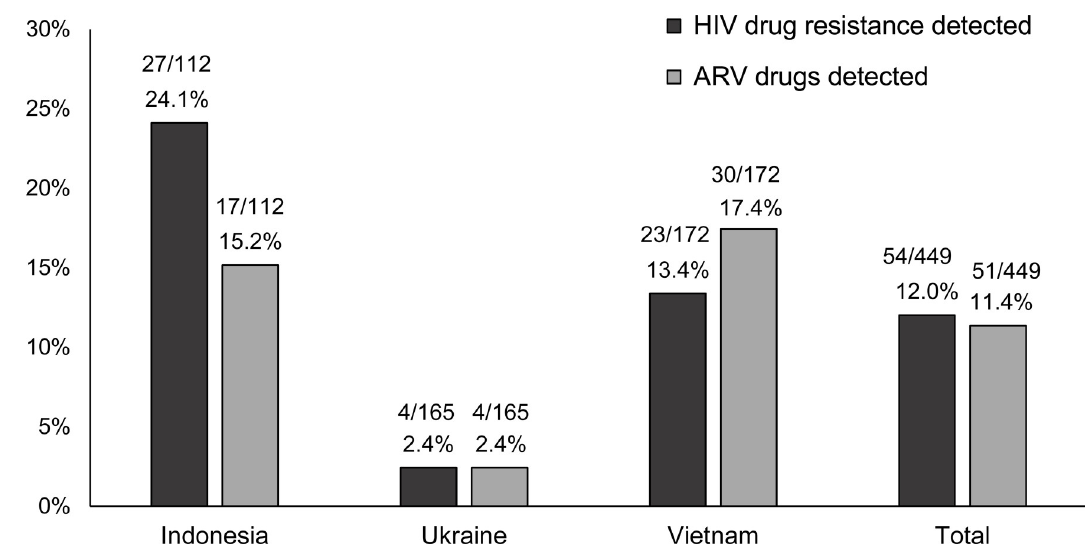
Fig 2. Prevalence of HIV drug resistance and antiretroviral drug use. The figure shows a summary of study findings. Results are presented by study site and overall (Total). The graph shows the proportion of participants with HIV drug resistance (dark bars) and the proportion of participants who had antiretroviral drugs detected (light bars). Abbreviation: ARV, antiretroviral.